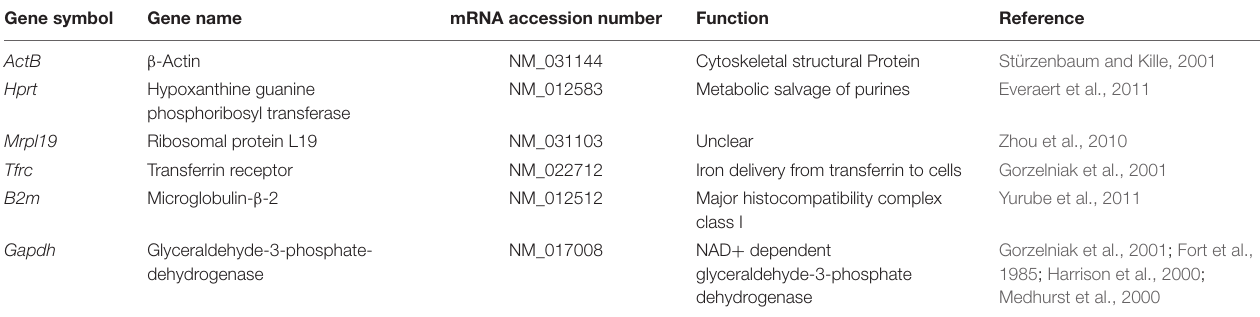
TABLE 2 | Panel of six candidate housekeeping genes selected for expression analysis.